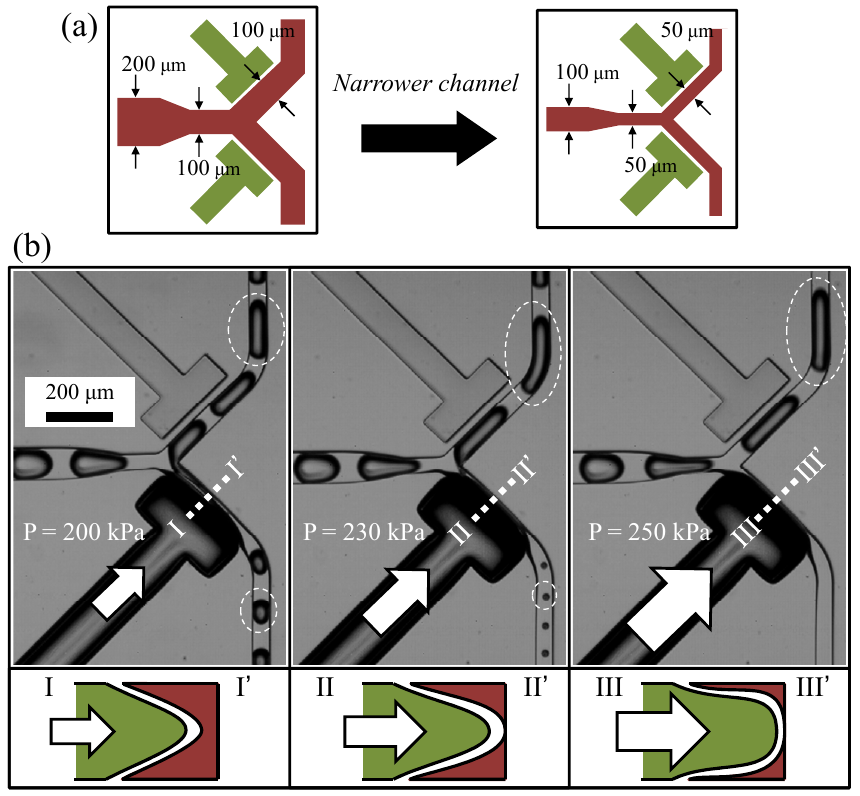
Figure 7. ( a ) Size change of division part for an effective use of the valve deformation. ( b ) Division results of large volume ratio with applied high pressure and cross section